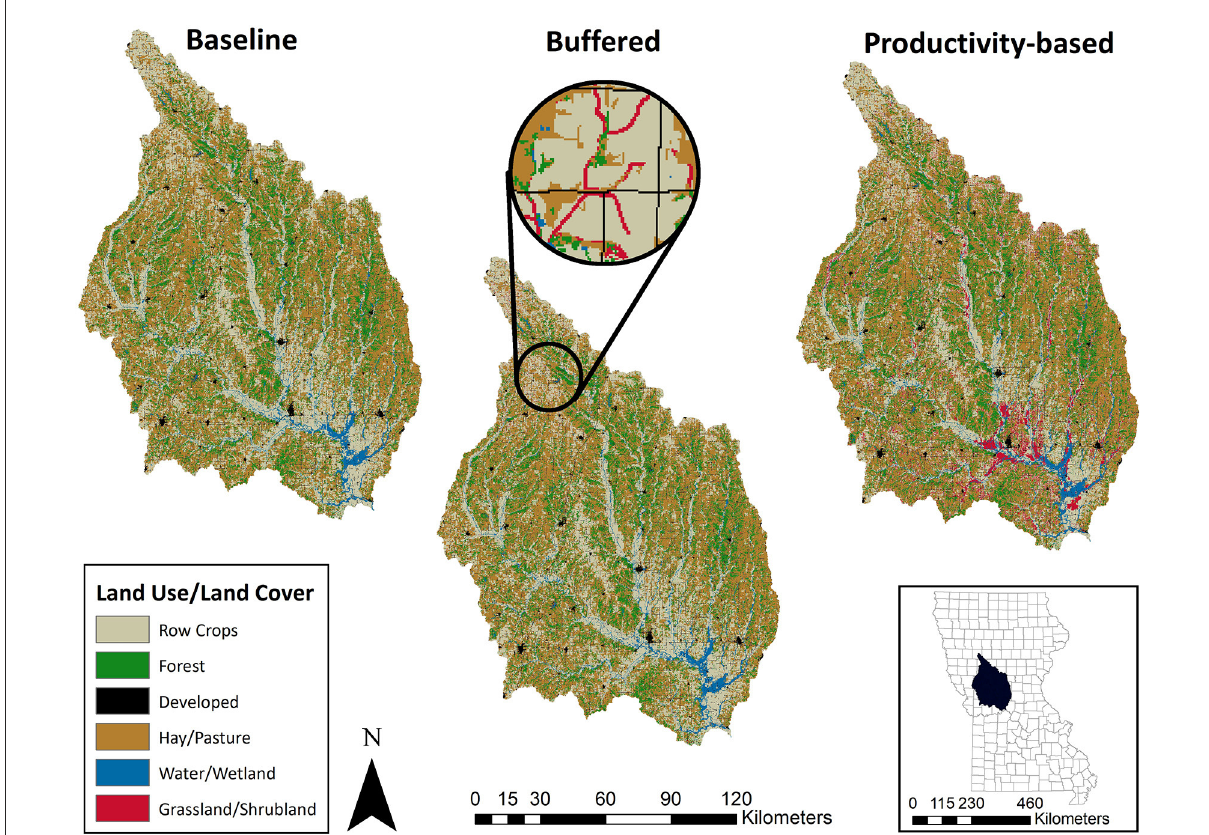
FIGURE1 Land use/land cover distributions for the Baseline, Buffered, and Productivity-based scenarios in the Grand River Basin, located in southwest Iowa and northwest Missouri, USA, based on the National Land Cover Dataset (Multi-Resolution Land Characteristic Consortium (MRLCC),